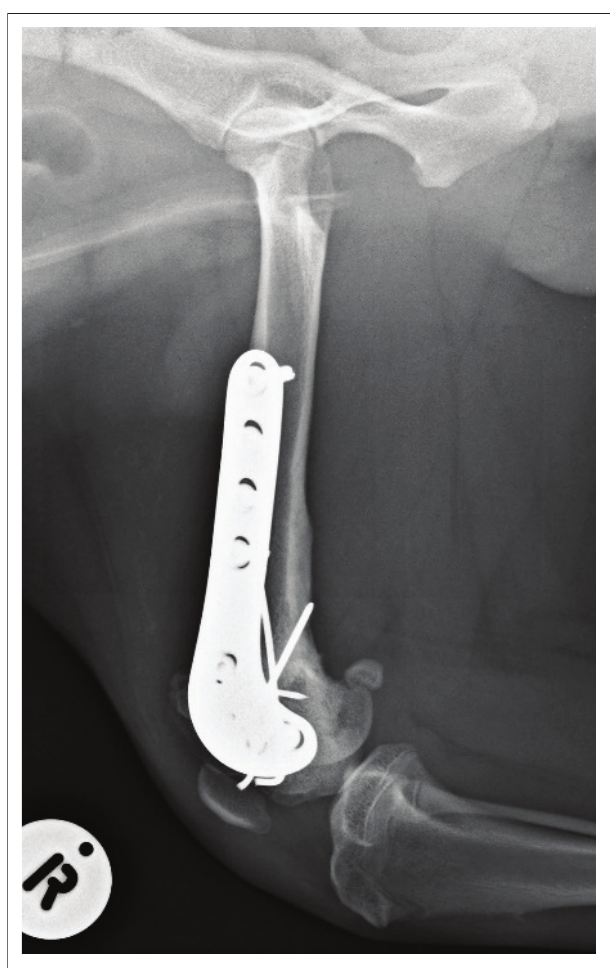
FIGURE 6: Radiographic image: Follow-up mediolateral view of the right femur obtained 6 weeks